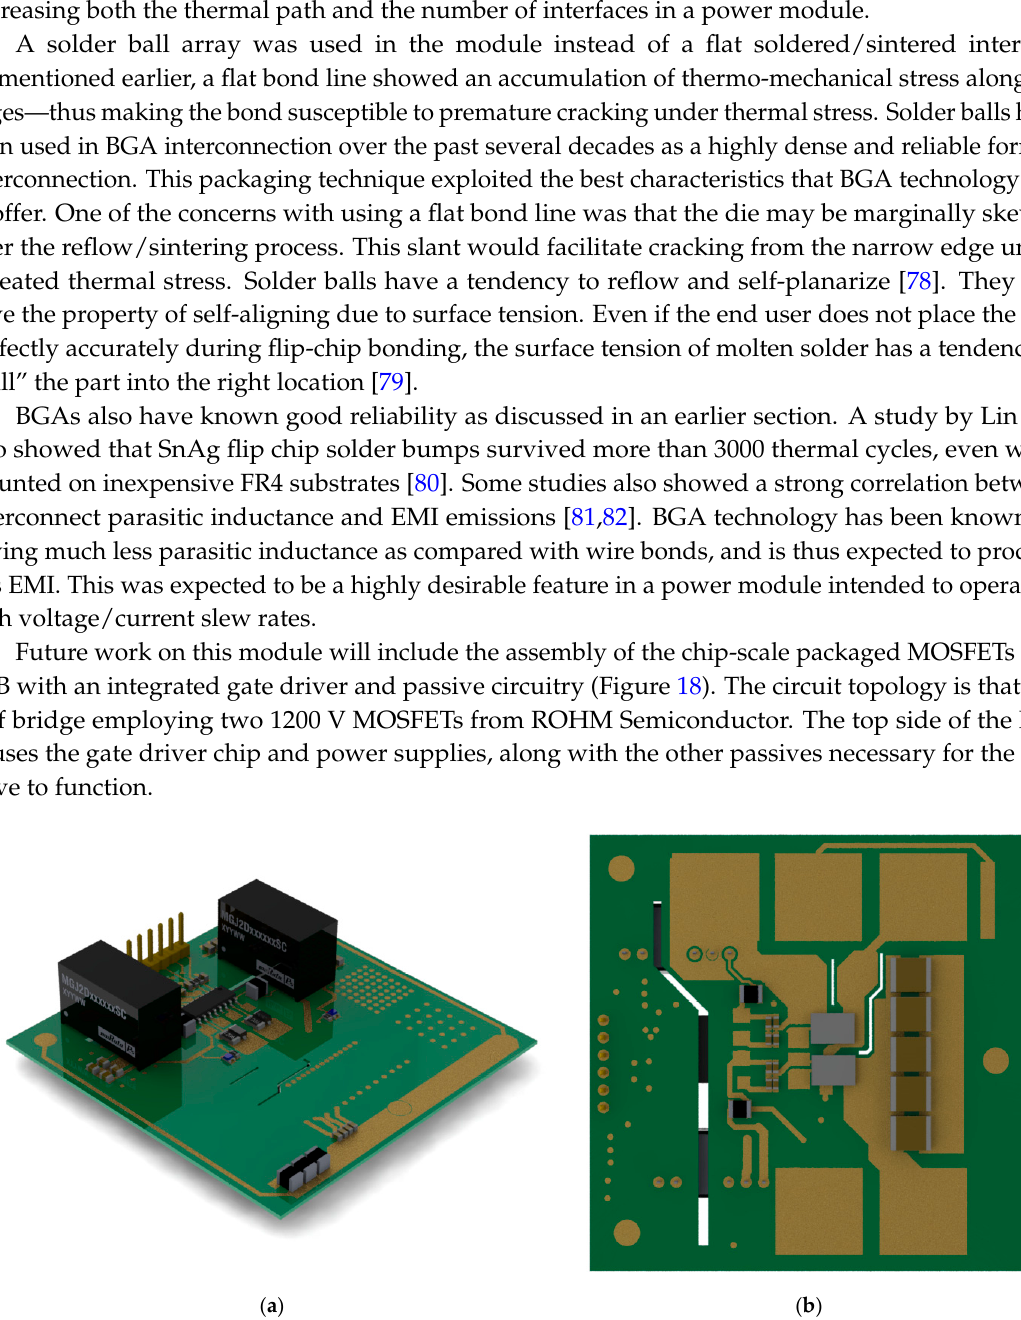
Figure 17. ( a ) A schematic showing the proposed chip scale MOSFET; and ( b ) a schematic showing the module implementation of the chip-scale MOSFET package.